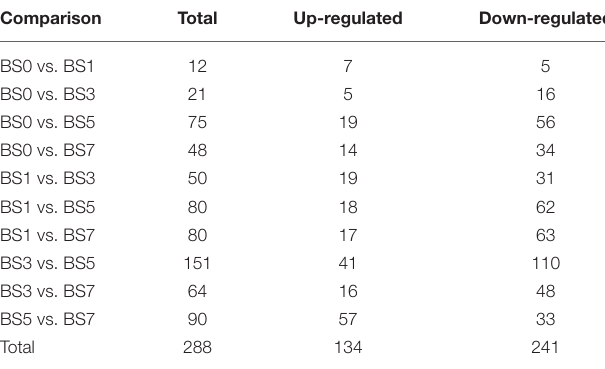
TABLE 4 | Number of differentially expressed miRNA in peripheral blood of cow induced by S. aureus at different times.